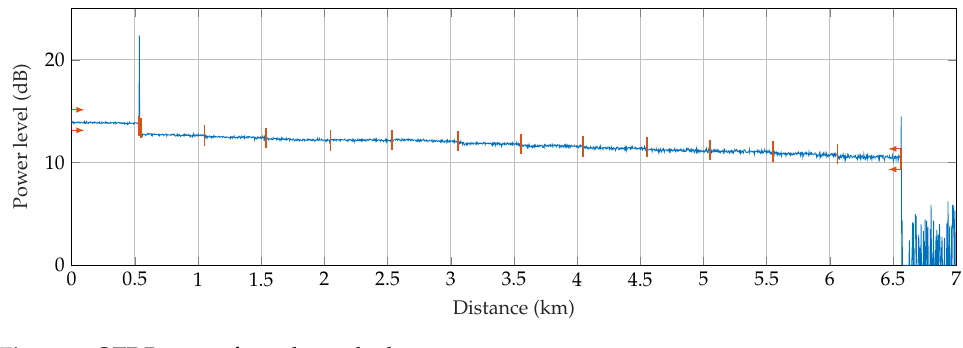
Figure 5. OTDR report from the testbed.